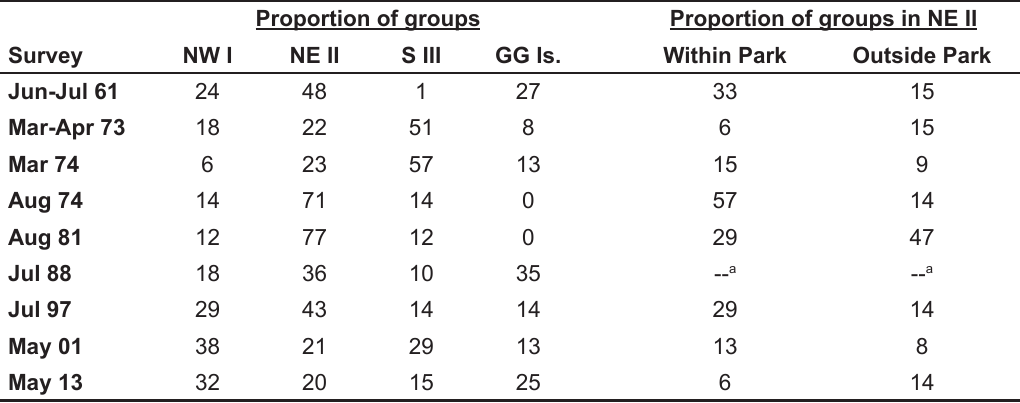
Table 1. Proportion of caribou groups relative to survey strata (Fig. 1) for Bathurst Island and the Gov- ernor General Islands, and for within and outside the proposed Park boundary in the northeast stratum, derived from figures in the survey reports, NU,